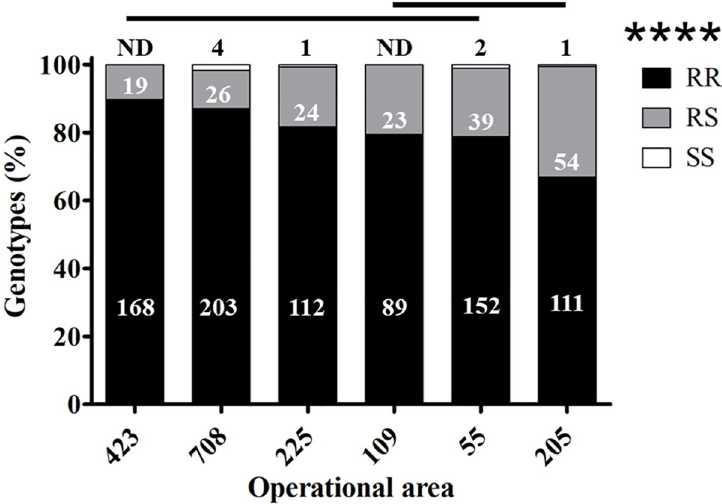
Fig 8. Percent of each genotype (RR, RS, and SS) of Cx . quinquefasciatus from per area. ���� P < 0.0001 calculated by Chi-square. Horizontal lines above bars indicate the areas which are not significantly different ( P < 0.05). The numbers in the graph refer to the numbers of mosquitoes analyzed for each area: in black on the top of each bar are the number of susceptible (SS) mosquitoes; ND = non-detected susceptible mosquitoes; in white in the gray boxes are the number of heterozygous resistant (RS), and in white in black boxes are the number of homozygous resistant (RR).